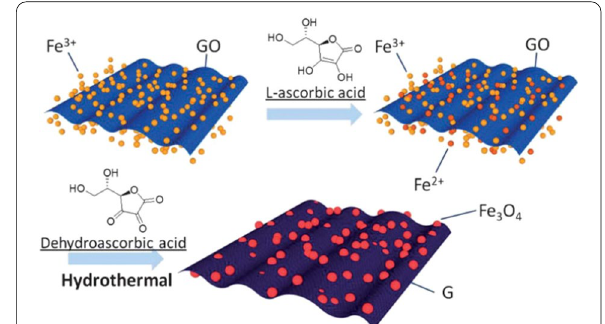
Fig. 9 Schematic illustration of the formation process of USIO/G. Reprinted with Permission from [127]. Copyright, Royal Society of Chemistry